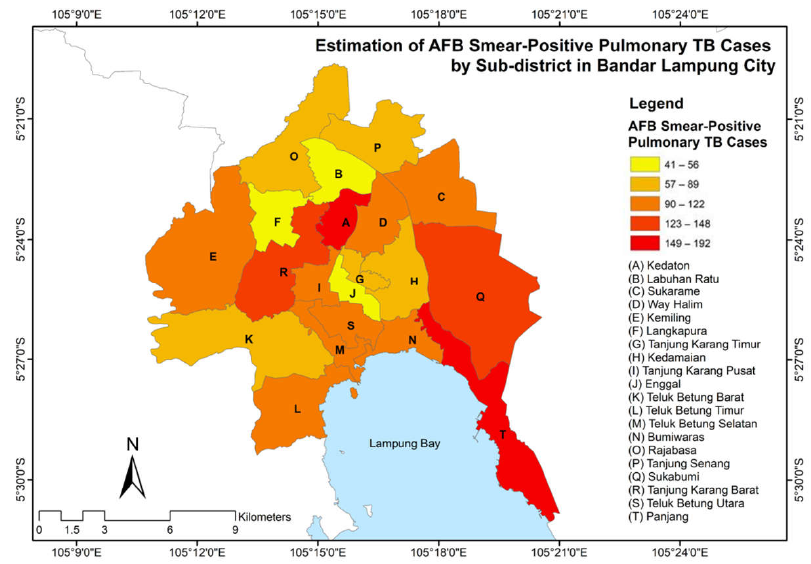
Figure 3. Spatial distribution of AFB smear-positive pulmonary tuberculosis (TB) cases in Bandar Lampung in 2020.